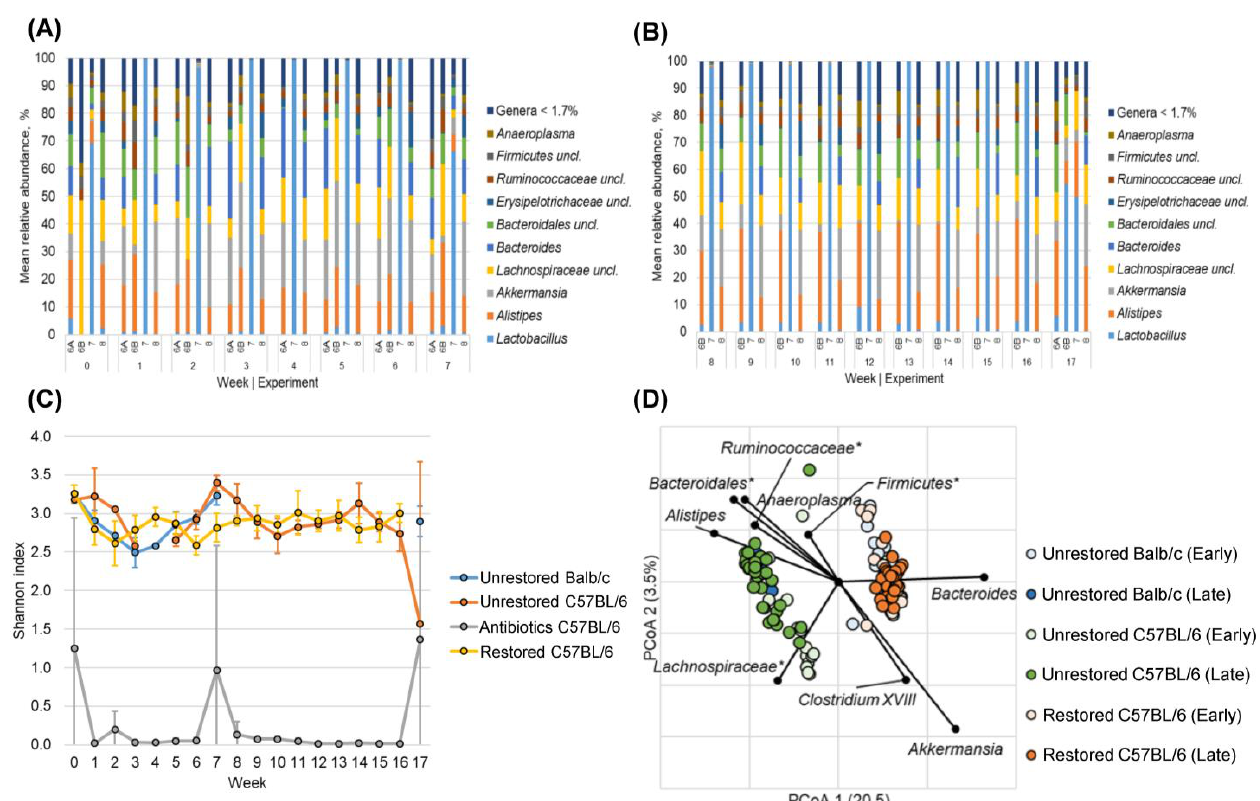
Figure 3. Microbiome composition and diversity in C57BL/6 mice. ( A ) Percentage of the relative abundance of bacterial genera (W0-W7) in EXP6A (Balb/c unrestored), EXP6B (C57BL/6 unrestored), EXP7 (C57BL/6 + ABX), and EXP8 (C57BL/6 C57BL/6 restored) following AOM/DSS administration. Genera that accounted for <0.7% of mean sequence reads were consolidated for clarity. ( B ) Percentage of the relative abundance of bacterial genera (W8-17). ( C ) Longitudinal average Shannon index, with groups shown in blue (unrestored Balb/c), orange (unrestored C57BL/6), yellow (restored C57BL/6), and gray (antibiotics C57BL/6). ( D) Principal coordinates analysis with correlated taxa associated with ordination position on either axis (Spearman p > 0.05) are overlaid on the PCoA plot. (*) Indicates genera that could not be further classified.